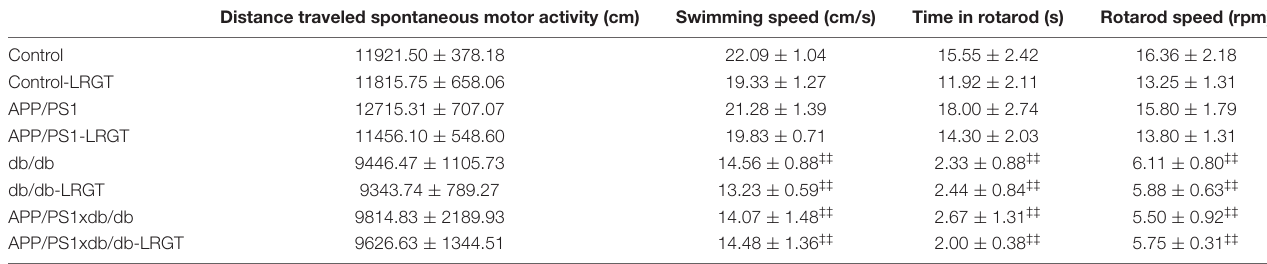
TABLE 1 | Motor activity assessment on liraglutide (LRGT)-treated mice. Distance traveled spontaneous motor activity